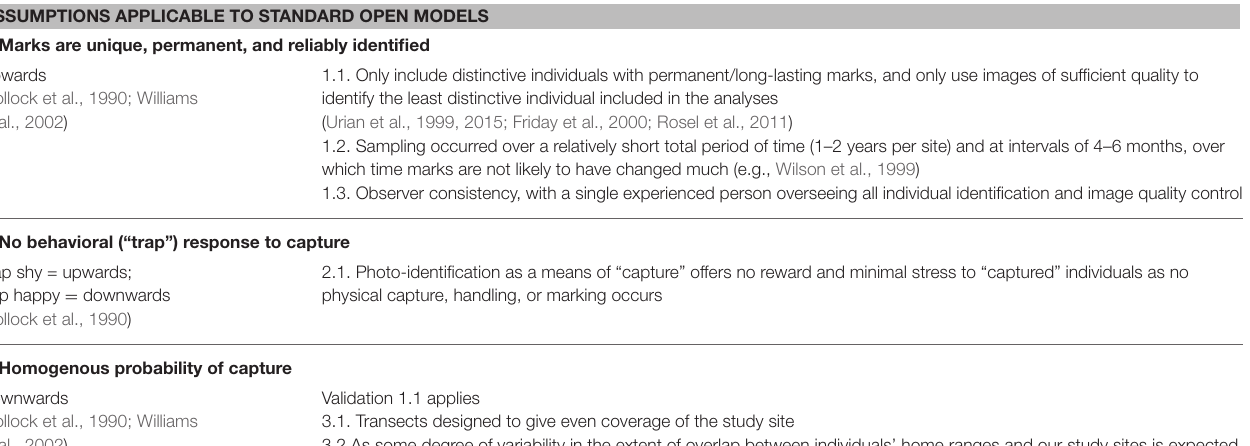
TABLE 2 | Validation of assumptions for capture-recapture models fitted to the data. Direction of bias in abundance estimate if